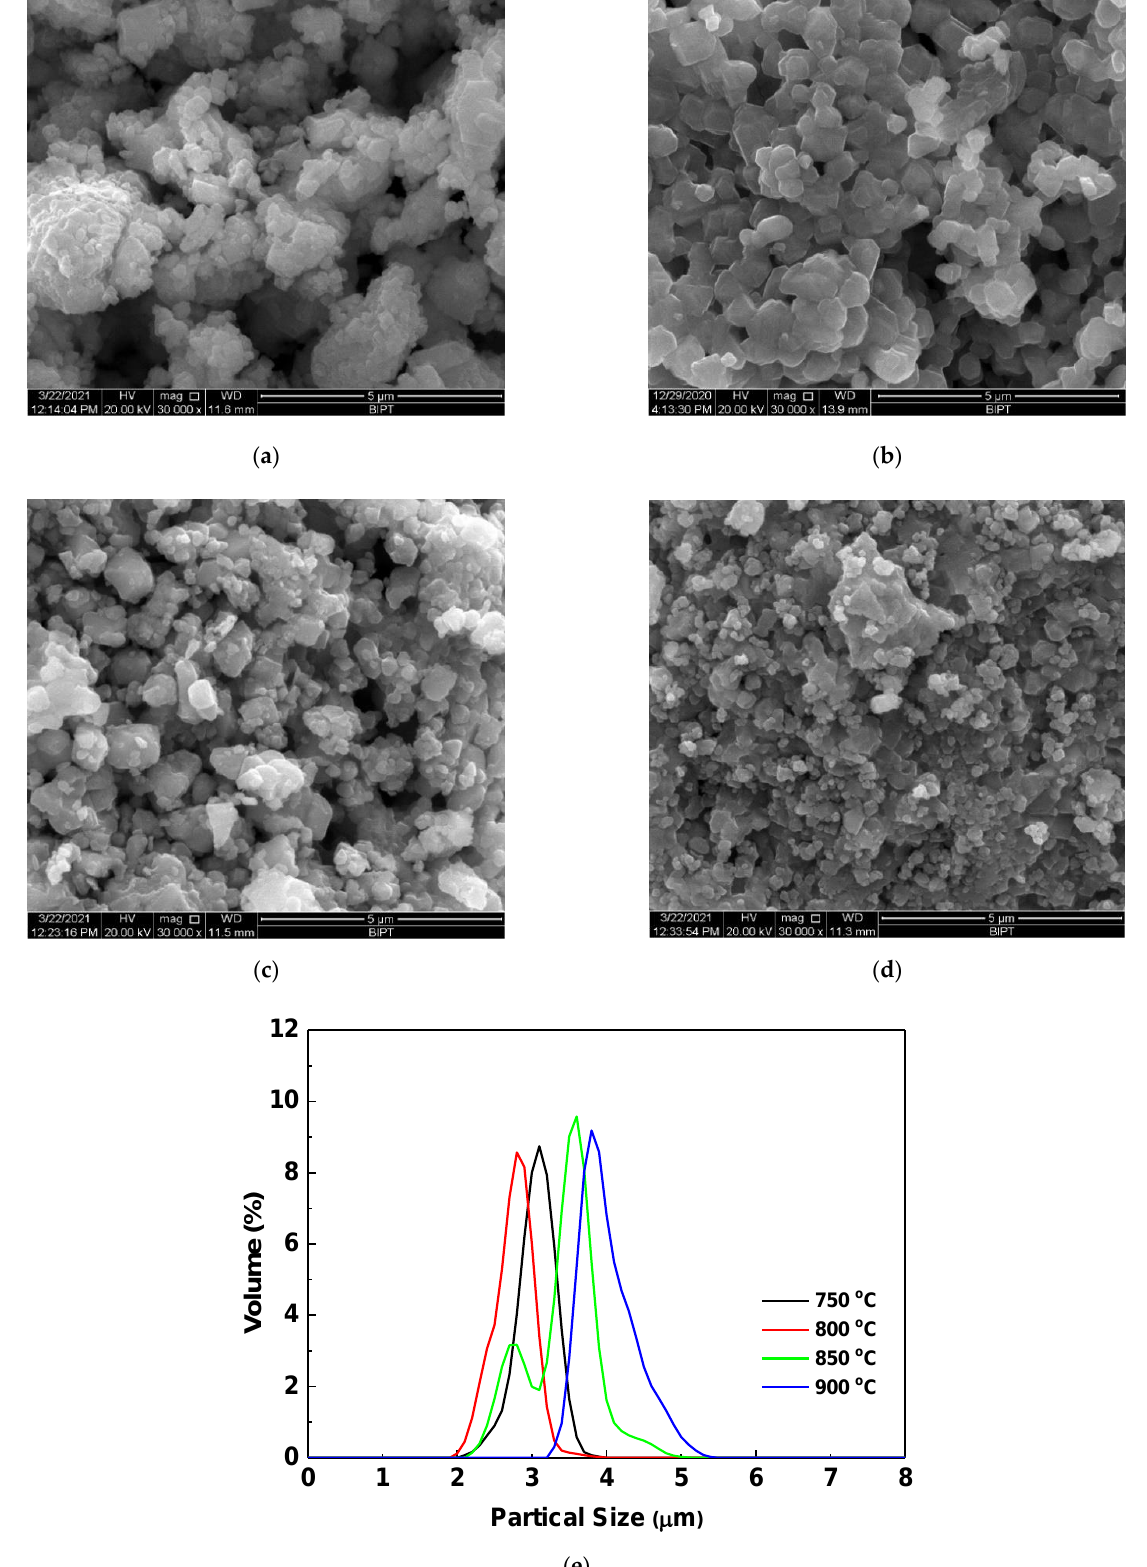
Figure 3. Particle morphology and particle size distribution analysis. (1) Scanning electron microscope (SEM) images of LiNi 2/3 Co 1/6 Mn 1/6 O 2 prepared at 700 ◦ C ( a ), 800 ◦ C ( b ), 850 ◦ C ( c ) and 900 ◦ C ( d ). (2) Particle size distribution ( e